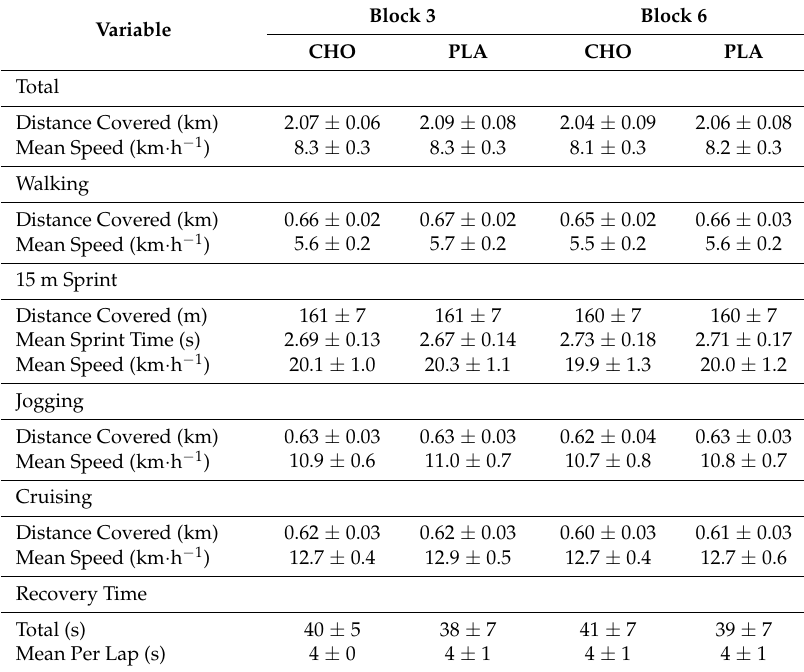
Data are mean ± SD. CHO: carbohydrate trial; PLA: placebo